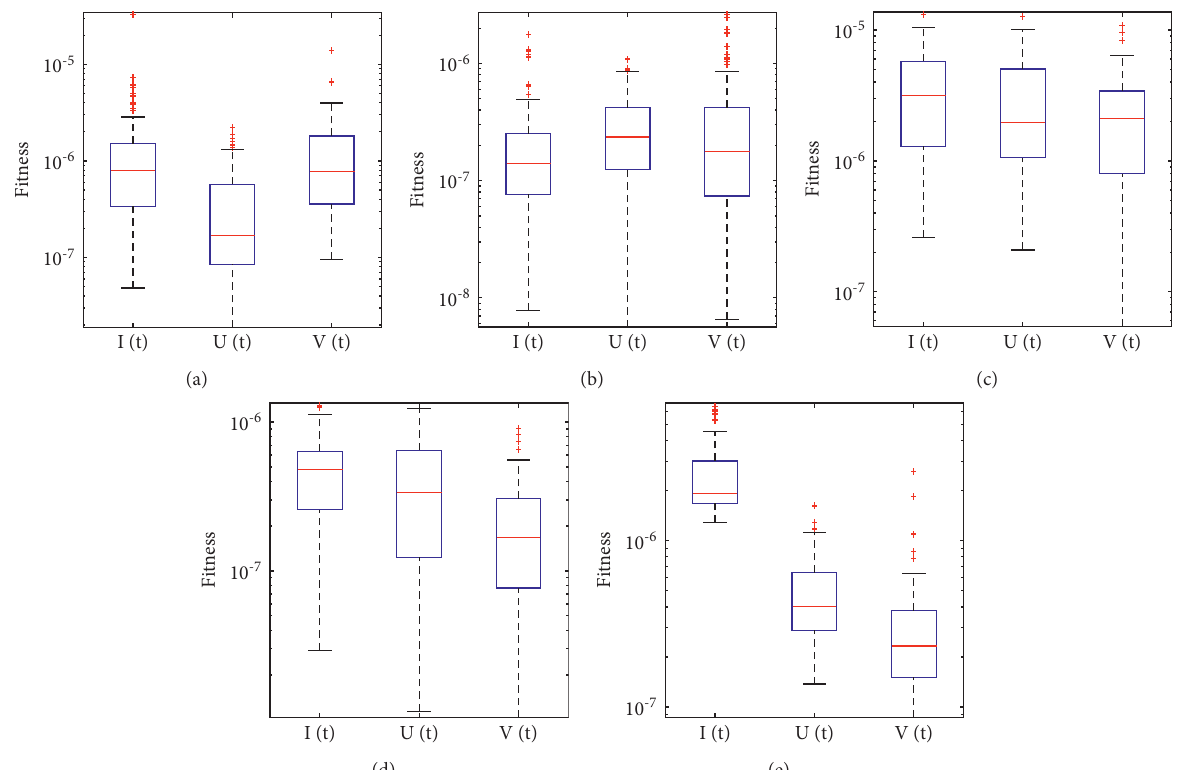
Figure 10: Fitness evaluation through box plots. (a) Fitness of problem 1, (b) fitness of problem 2, (c) fitness of problem 3, (d) fitness of problem 4, and (e) fitness of problem 5.